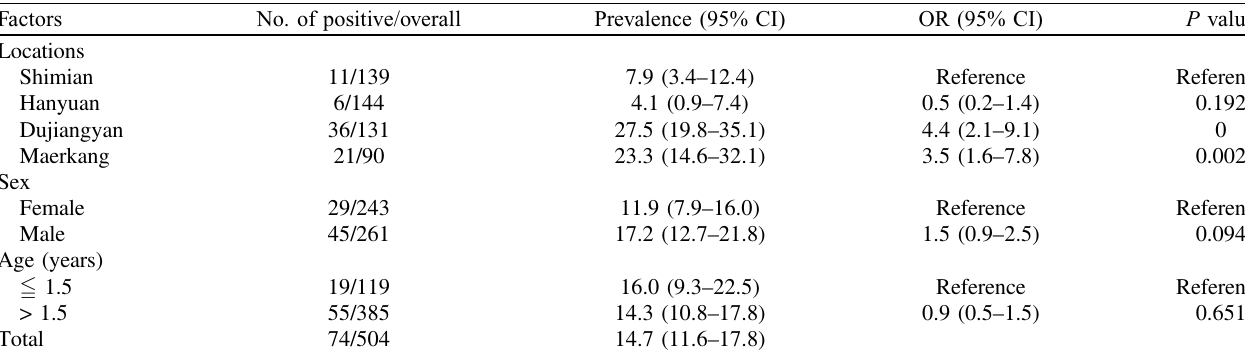
Table 1. Factors associated with the prevalence of Blastocystis in forest musk deer in